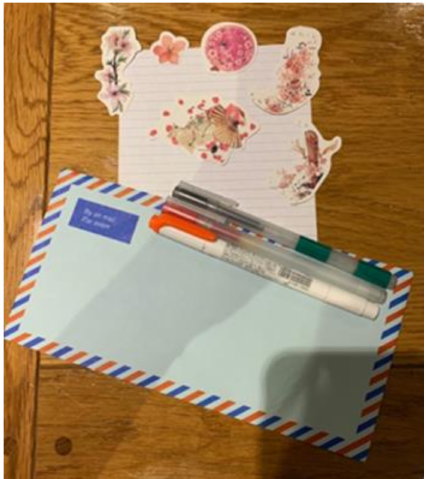
Figure 3. “ So I’ve been writing letters to my friends. A few of them are within walking distance so I just pretend that I’m mailing it by writing their address and drawing a stamp making it look cute. Writing letters has been a fun way to just chat to them in a way we wouldn’t do over the phone or in person because it feels too ‘cringe’ . . . I think it’s just our generation who doesn’t get letters anymore. Whenever you do get a letter, it’s quite exciting . . . it was kind of like the thrill of it. Of just getting a letter through the post with your name